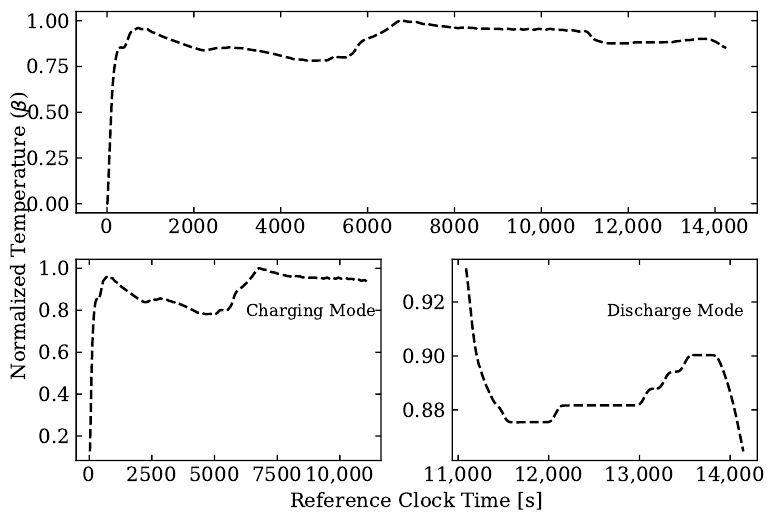
Figure 10. Normalized temperature data from the thermocline inlet location: reference value, T o = 354 ◦ C.